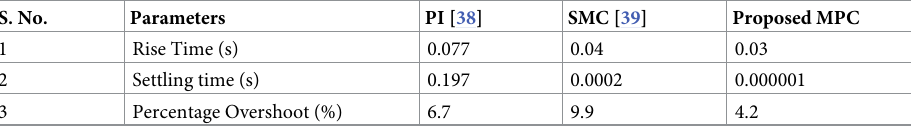
Table 4. Comparison of MPC with other techniques. S.